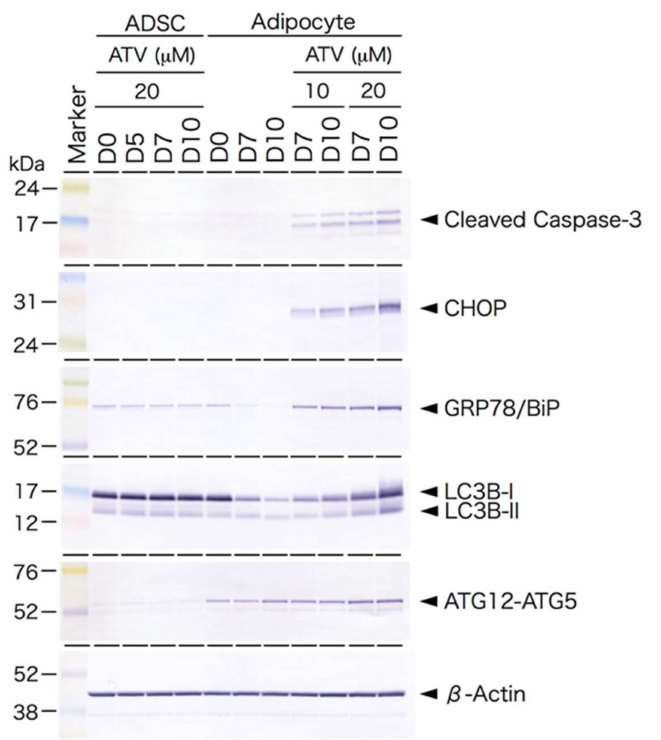
Figure 5. Western blot analysis of endoplasmic reticulum (ER) stress-mediated unfolded protein response (UPR) and autophagy-related proteins ADSCs cultured in a serum free-medium, treated with 20 µ M ATV for the indicated time (ADSC). D0 indicates the day when ATV was administrated. ADSCs, cultured in serum-free medium until they reached confluence, were cultured in adipogenic differentiation medium for the indicated time with or without ATV at 10 µ M or 20 µ M for the indicated time (Adipocyte). D0 indicates the day when the medium was changed to differentiation medium and ATV was concurrently added. Protein samples (8 or 16 µ g) were electrophoresed on SDS-polyacrylamide gel, electrophoretically transferred to a polyvinyl difluoride membrane, and the membrane was incubated with the indicated primary antibodies. CHOP, CCAAT-enhancer-binding (C/EBP) protein homologous